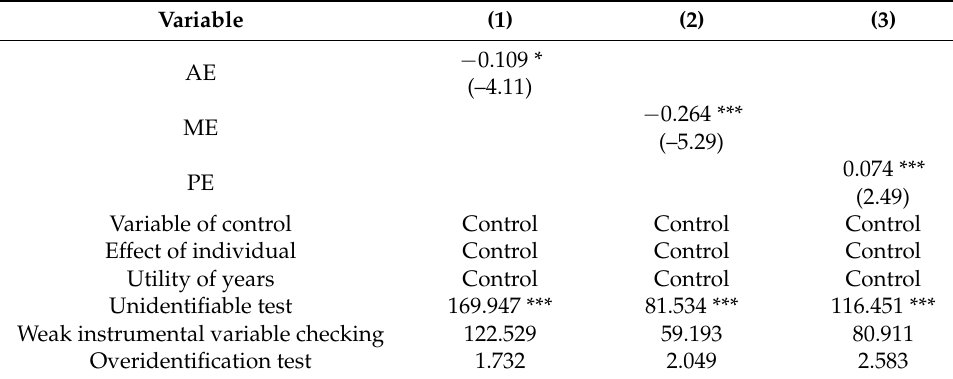
Table 4. Endogenic